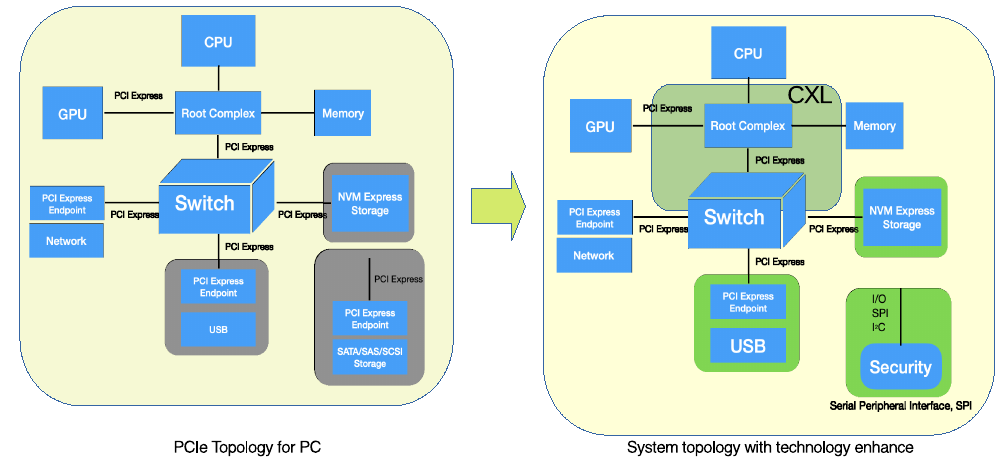
Figure 2. PC structure with PCIe topology